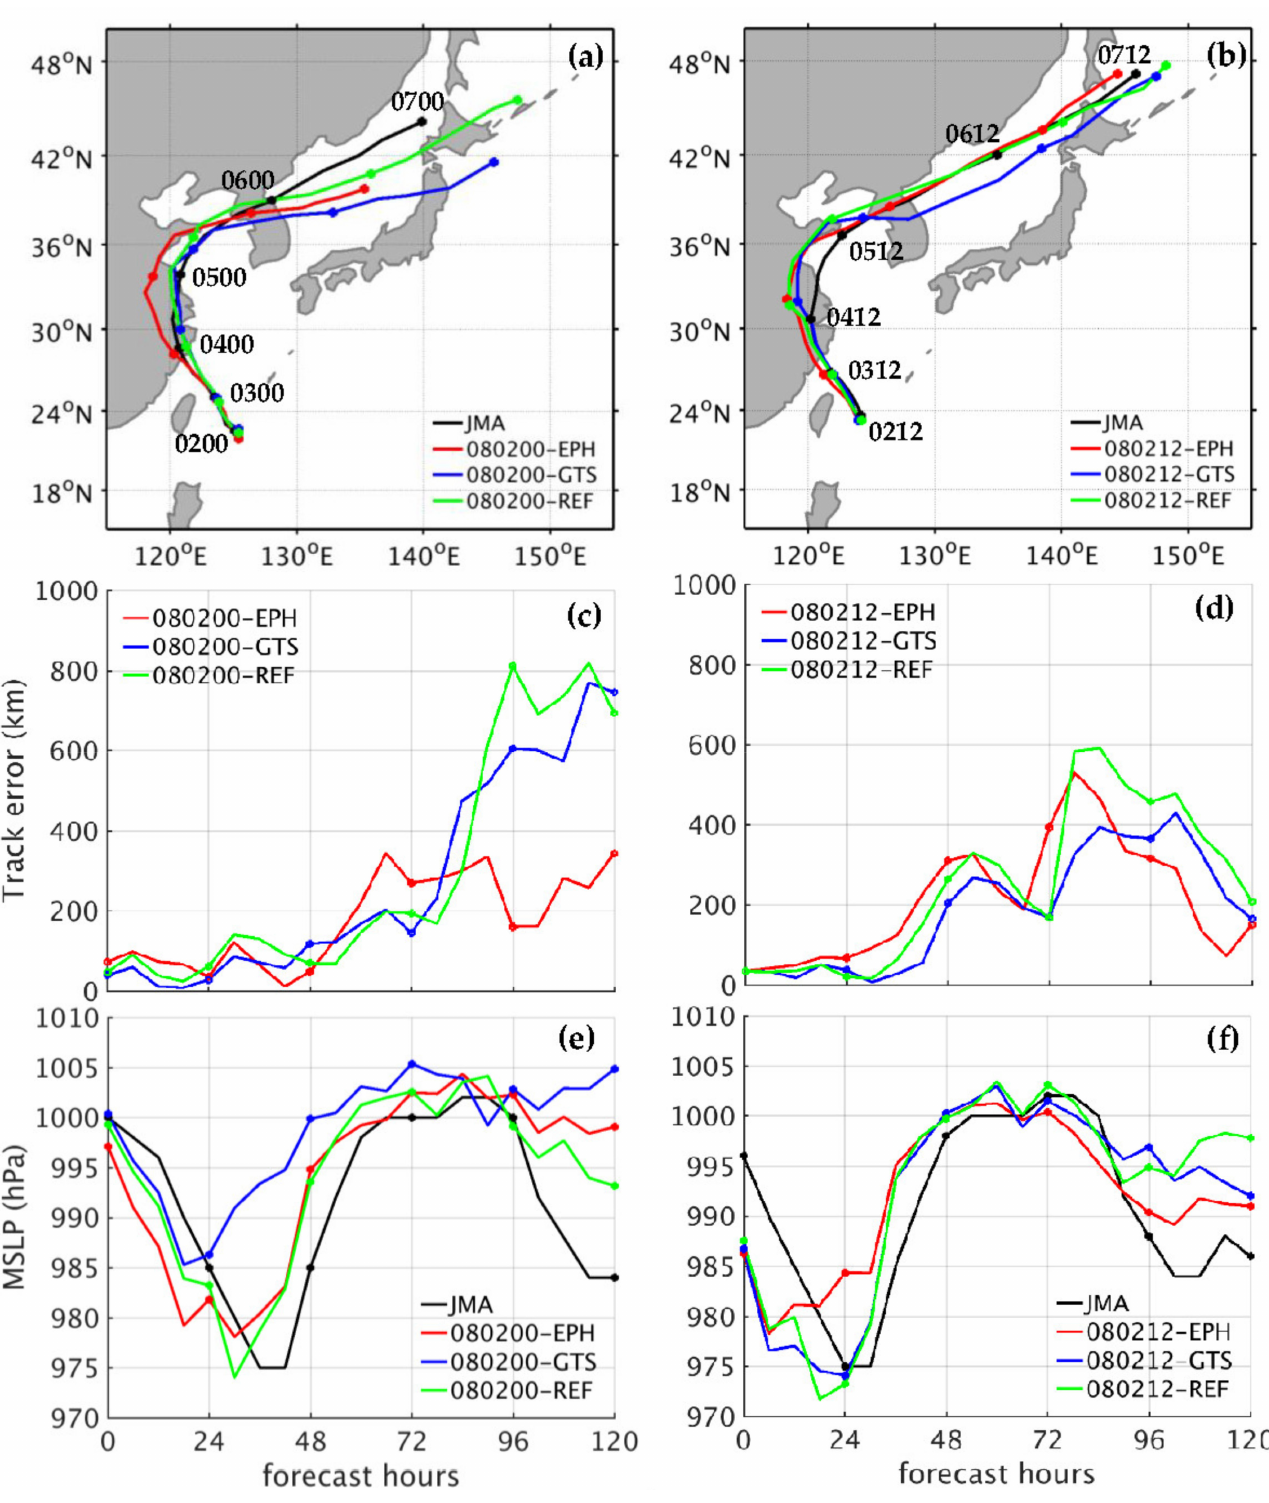
Figure 14. ( a ) Simulated tracks of Hagupit for experiments, GTS (blue), REF (green), and EPH (red), and the best tracks from JMA (black). The simulated time was from 0000 UTC 2–7 August 2020. ( b ) as in ( a ) but for the simulated time from 1200 UTC 2–7 August 2020. ( c , d ) as in ( a , b ), respectively, but for track error (km). ( e , f ) as in ( a , b ), respectively, but for MSLP (hPa). Circle symbols in ( a , b ) mark the typhoon centers every 24